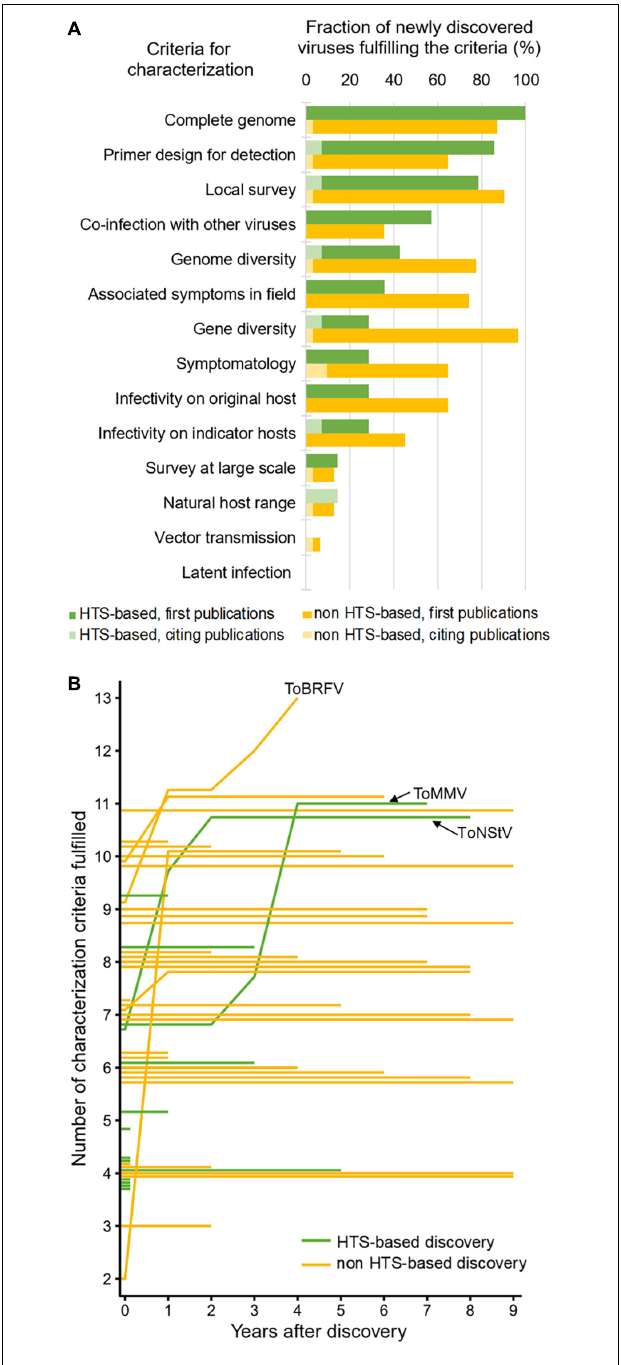
FIGURE 2 | Post-discovery characterization of new tomato-infecting viruses according to the literature review. Percentages of newly discovered virus species fulfilling each of the 14 characterization criteria are shown for viruses discovered by HTS or other methods (A) . Fulfillment of characterization criteria plotted through the years elapsed since the first report is shown as a line plot (B) , wherein each line represents a single virus and the evolution of its characterization; the lines corresponding to the emerging tomato brown rugose fruit virus (ToBRFV), and the first two tomato viruses discovered through HTS, tomato mottle mosaic virus (ToMMV) and tomato necrotic stunt virus (ToNStV), are